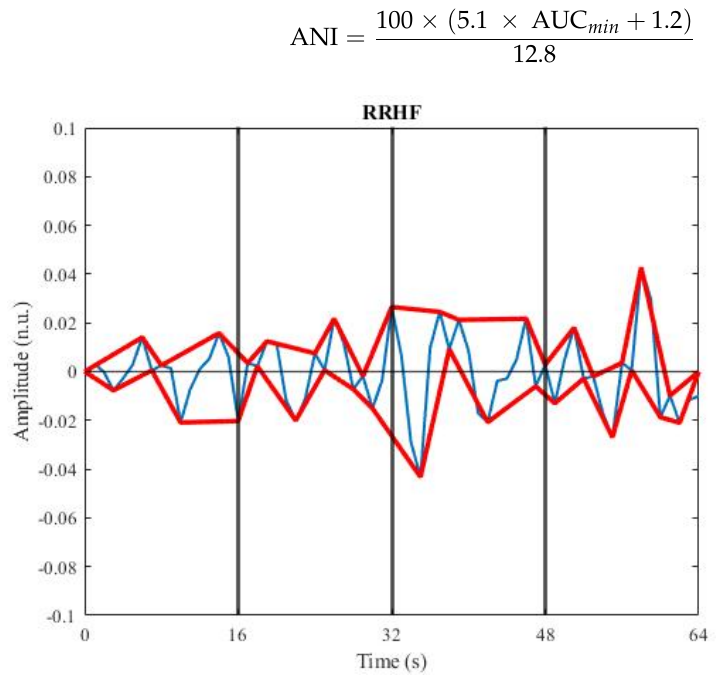
Figure 4. Plot of RRHF. Blue: RRHF curve; red: the lines which connect all the local maxima and local minima points in the RRHF curve.